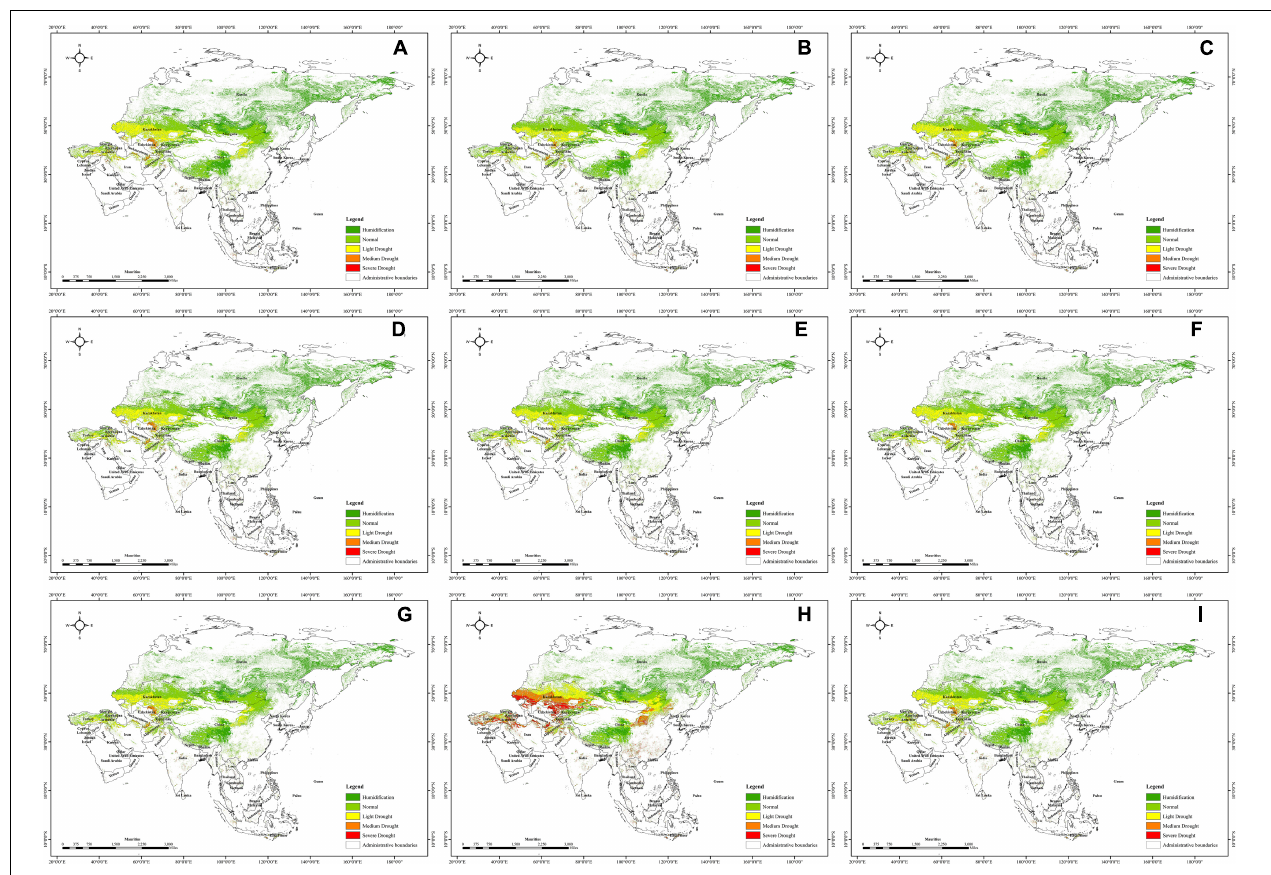
FIGURE 5 | TVDI in AGE for (A) 2010, (B) 2011, (C) 2012, (D) 2013, (E) 2014, (F) 2015, (G) 2016, (H) 2017, and (I) 2018.